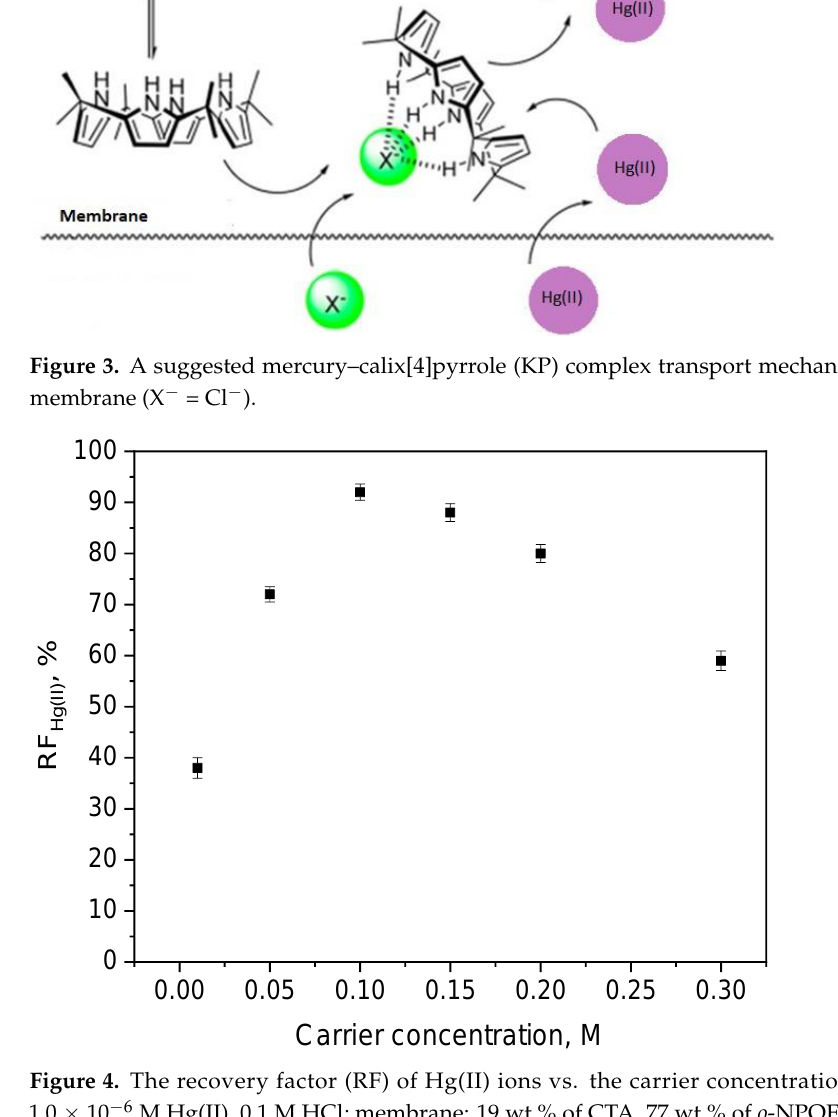
Figure 4. The recovery factor (RF) of Hg(II) ions vs. the carrier concentration. Source phase: 1.0 × 10 −6 M Hg(II), 0.1 M HCl; membrane: 19 wt.% of CTA, 77 wt.% of o -NPOE; receiving phase: 0.1 M